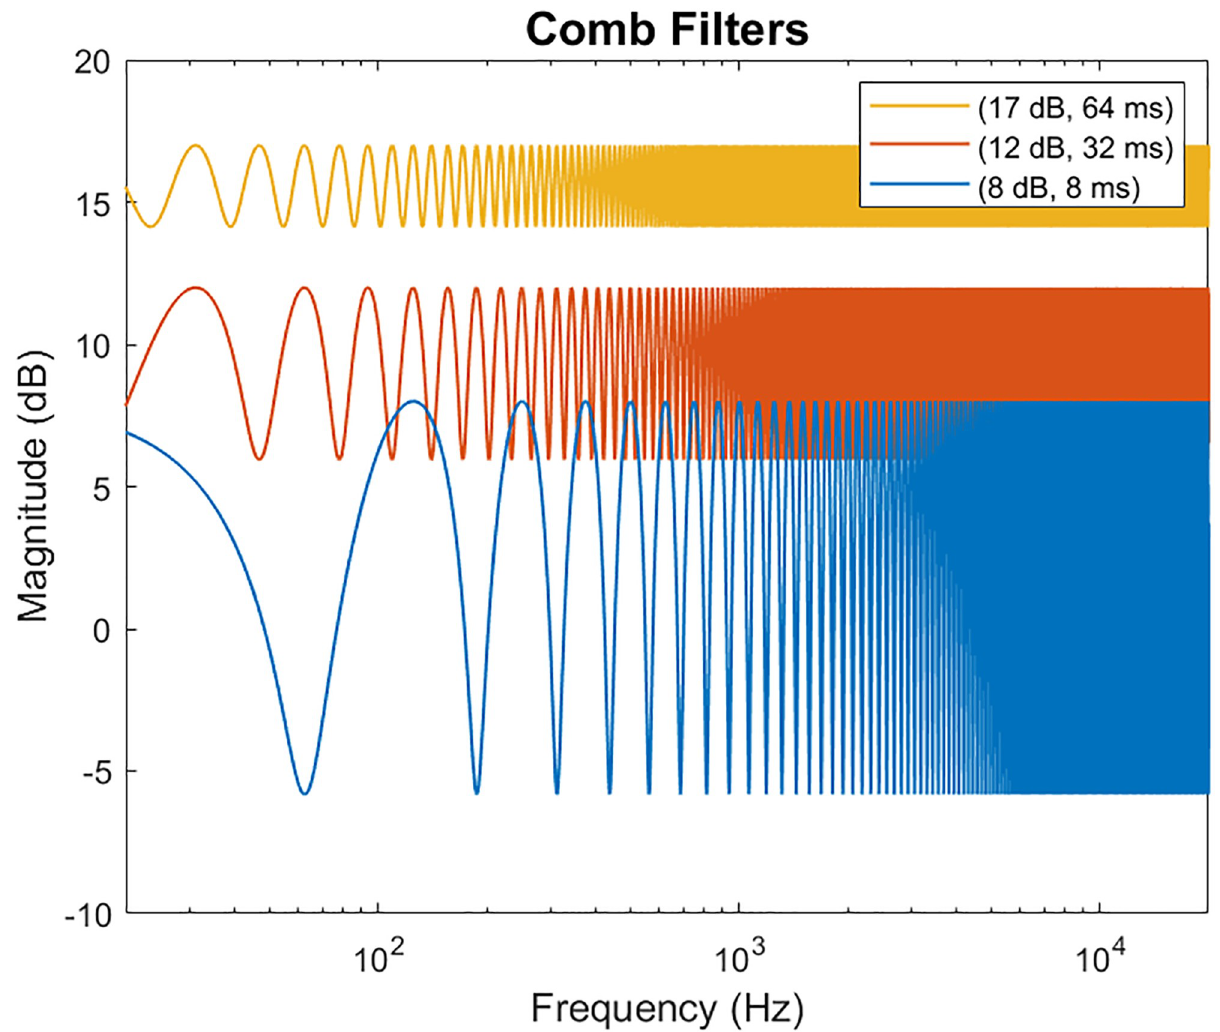
Fig 1. Comb filters. Comb filters as a result of 3 gain / enhancement pairs. Yellow: 17 dB, 64 ms, dip depth = 2.89 dB. Red: 12 dB, 32 ms, dip depth = 6.06 dB. Blue: 8 dB, 8 ms, dip depth = 13.82 dB.